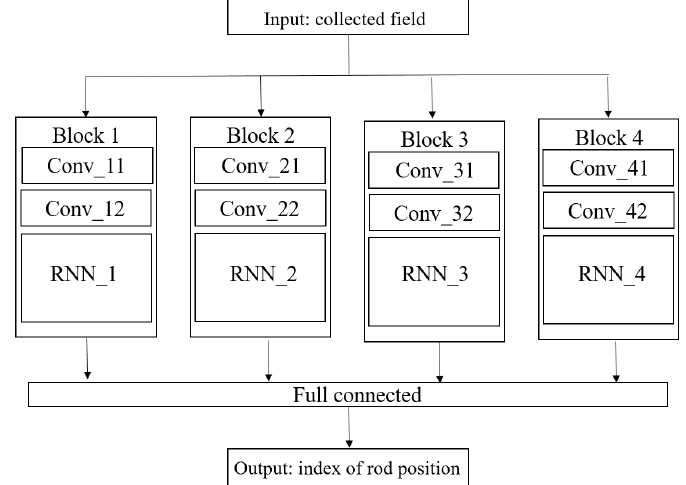
Figure 9. Architecture of the proposed combined RNN (CRNN)